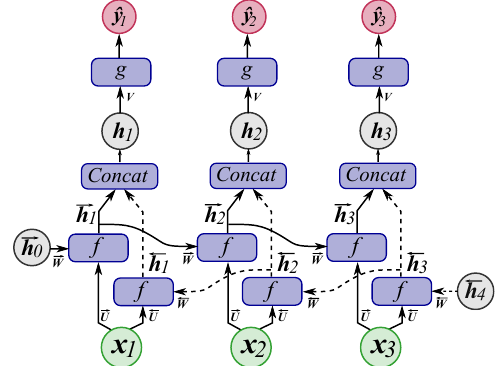
Figure 2. Bidirectional RNN for three time steps (Unfolded